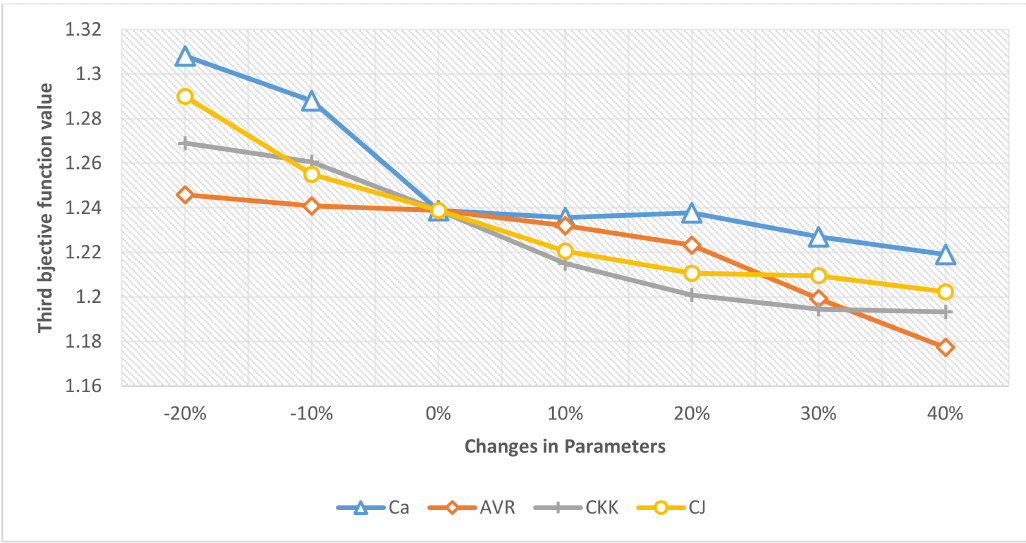
Figure 12. Sensitivity analysis of the third objective function by changing the important